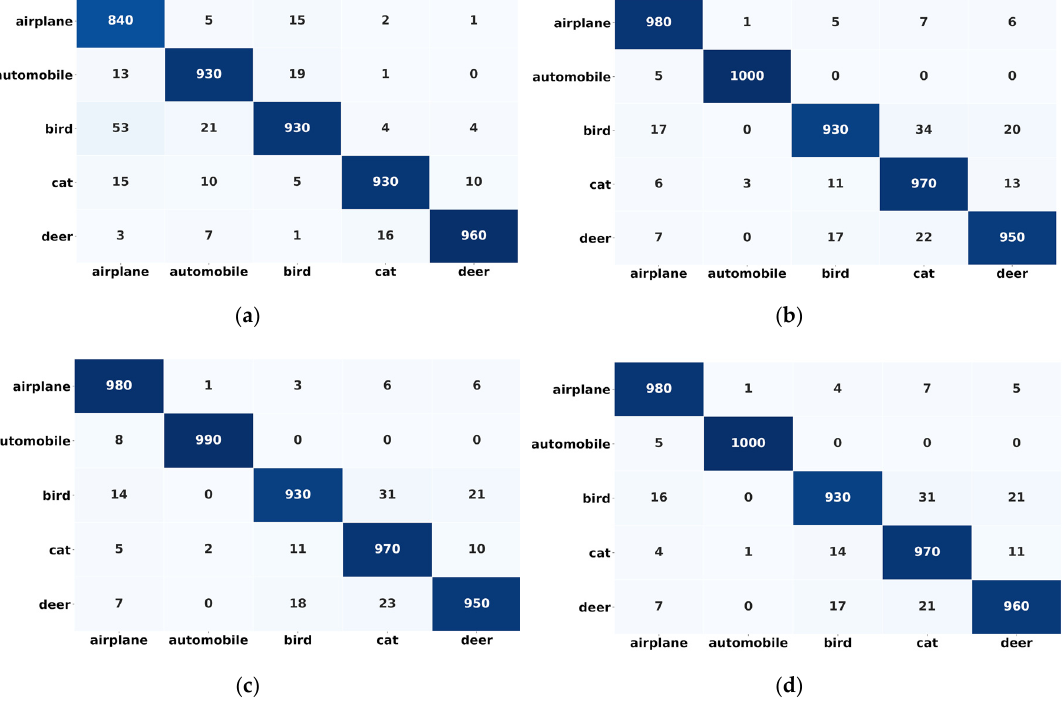
Figure 10. Confusion matrix of proposed framework and state-of-the-art shallow learning and deep learning approaches after novel class arrival issue: ( a ) Confusion matrix for ameliorated adaptive CNN ensemble (proposed framework); ( b ) Confusion matrix for Ensemble CNN; ( c ) Confusion matrix for Ensemble Support Vector Machine; ( d ) Confusion matrix for Random Forest.